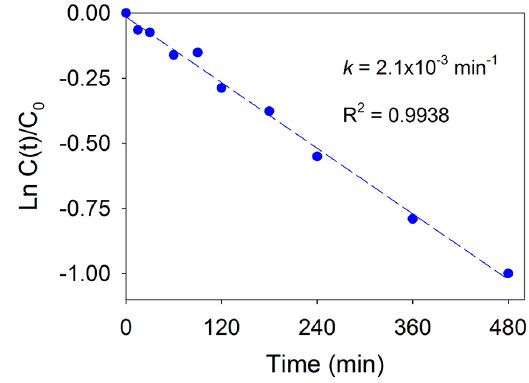
Figure 8. Current vs. Time curve for copper reduction: Electrolysis with TiO films without ( □ ) and with PEG ( ○ ) and photo‑assisted 2 electrolysis without ( ■ ) and with PEG ( ● ).